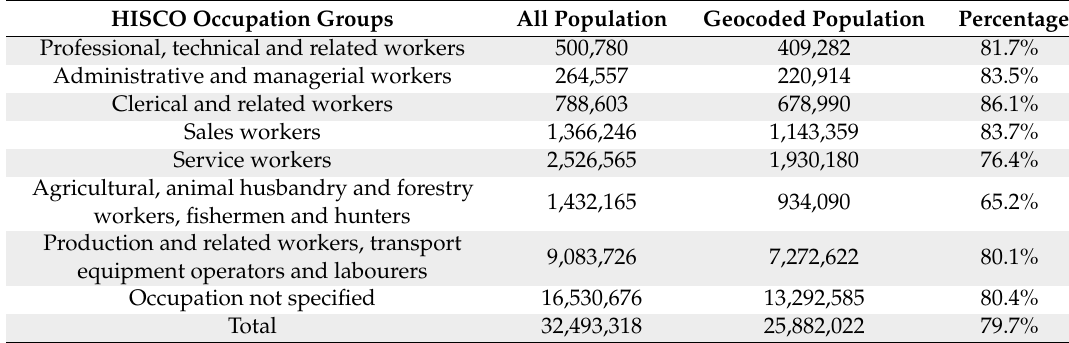
Table 4. Numbers and percentages of individuals with geocoded addresses by the HISCO occupational